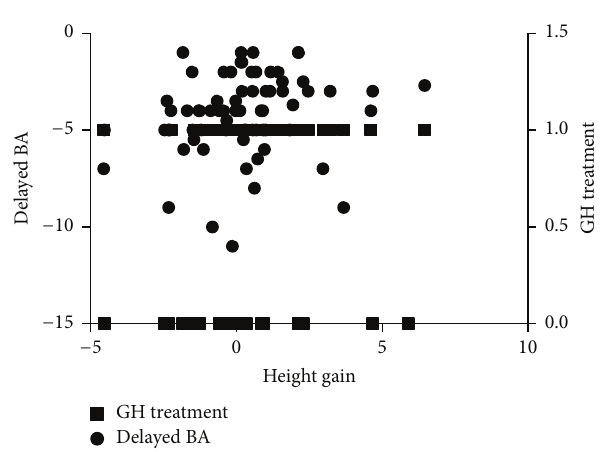
Figure4:Regressionanalysesforheightgain.horizontalaxis:height gain; left vertical axis: delayed bone age; right vertical axis: GH treatment (yes for 1 and no for